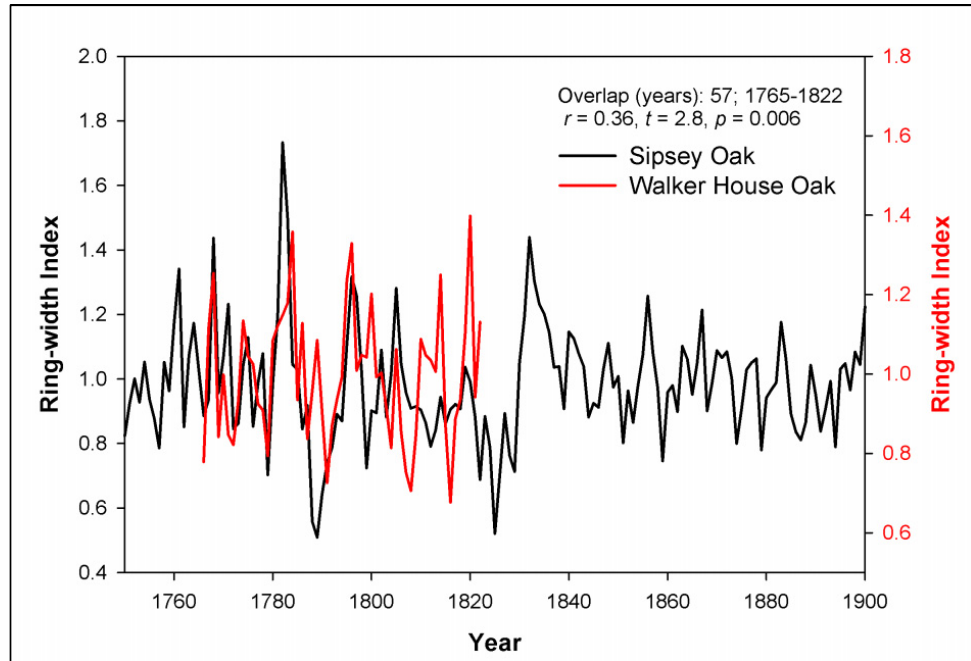
Figure 6. The Walker House oak chronology (red) plotted with the white oak reference chronology from the Sipsey Wilderness (black). The Walker House oak chronology is anchored in time against the reference chronology from 1765 to 1822 ( n = 57 years, r = 0.36, t = 2.80, p < 0.01).